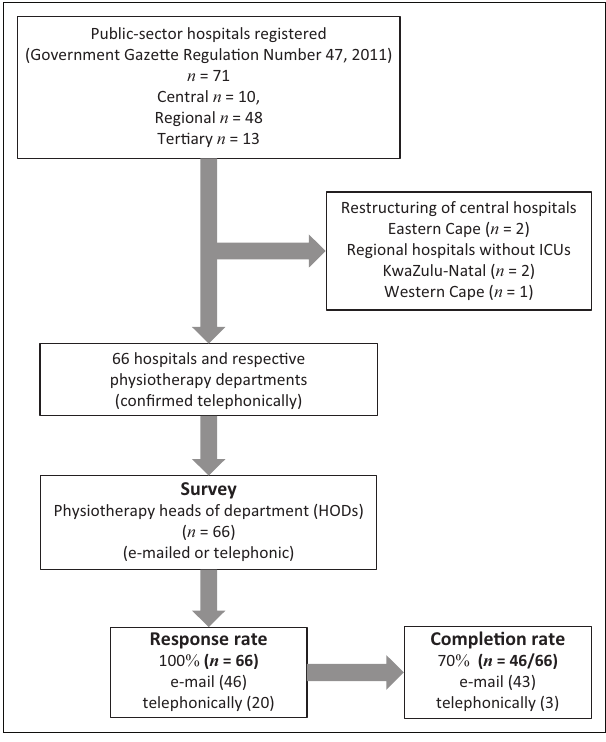
FIGURE 1: Flow diagram of